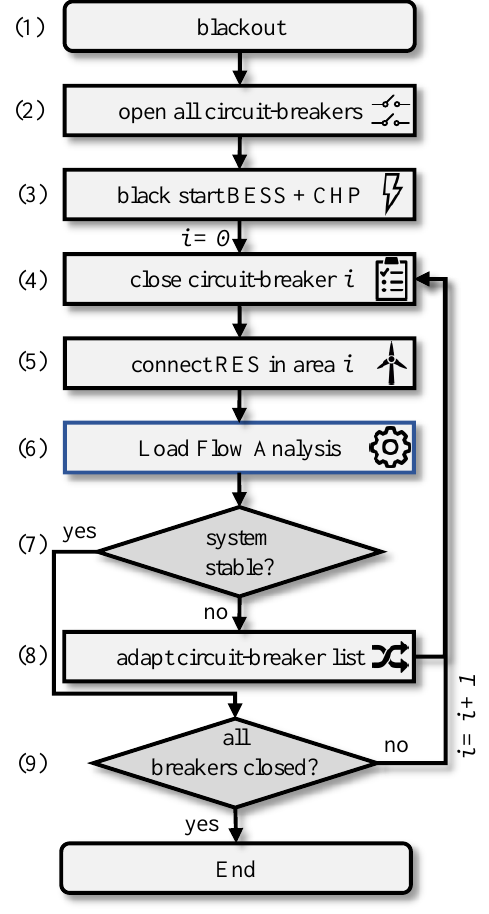
Fig. 3. Methodology for restoration process of a distribution grid with high penetration of RES